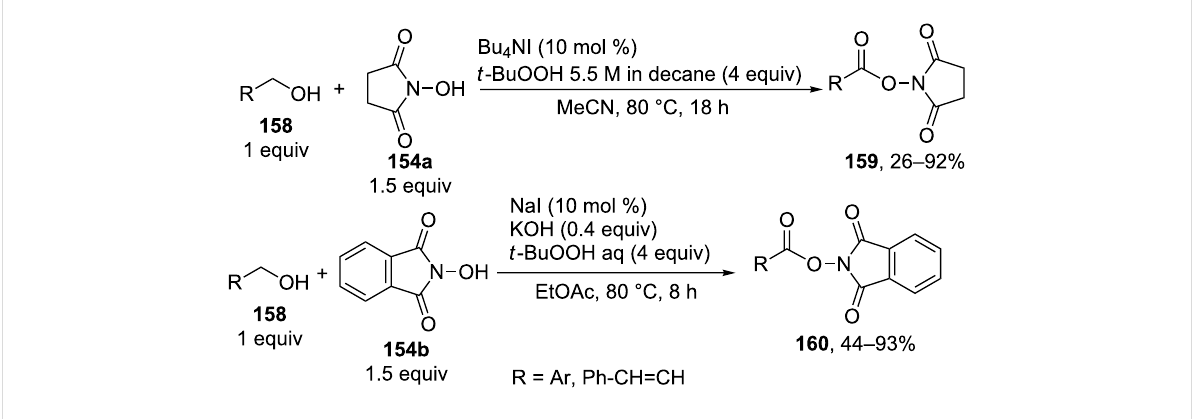
Scheme 32: Oxidative coupling of alcohols with N